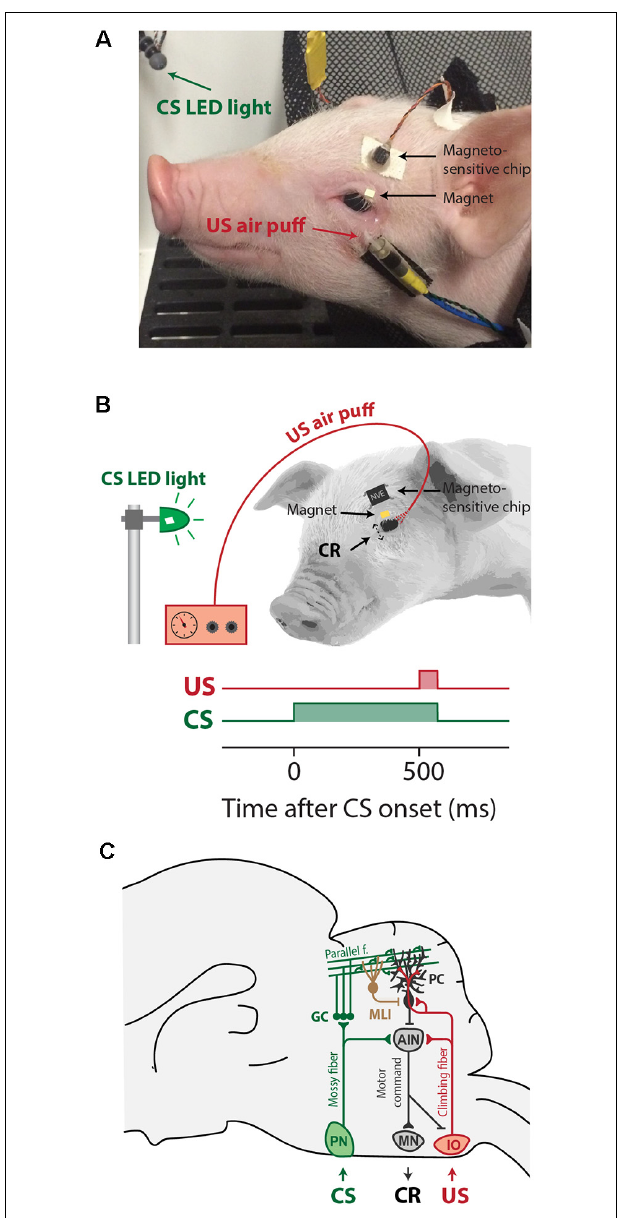
FIGURE 1 | Overview of eyeblink conditioning apparatus, trial parameters, and neural circuitries involved in Pavlovian eyeblink conditioning (A) Apparatus in place for eyeblink conditioning trials. The CS was a blue light-emitting diode (LED) light and the US was a mild air-puff applied to the cornea. Since pigs tend to move their heads a lot during the experiment, the equipment needed to deliver the air-puff US and record the eyelid position was attached to the pig’s face, while the pig remained comfortably in a hammock. (B) Simplified illustration of the apparatus attachments and trial parameters of CS (green) and US (red). We used a delay eyeblink conditioning paradigm, whereby the start of the CS preceded the onset of the US by 500 ms, and both CS and US co-terminated at 550 ms after CS onset. (C) Simplified illustration of the neural circuits underlying delay eyeblink conditioning. The CS is transmitted via the mossy fiber–parallel fibers system (green) to Purkinje cells in well-defined microzones in the cerebellar cortex. The same Purkinje cells receive input from the climbing fibers transmitting the ( Continued